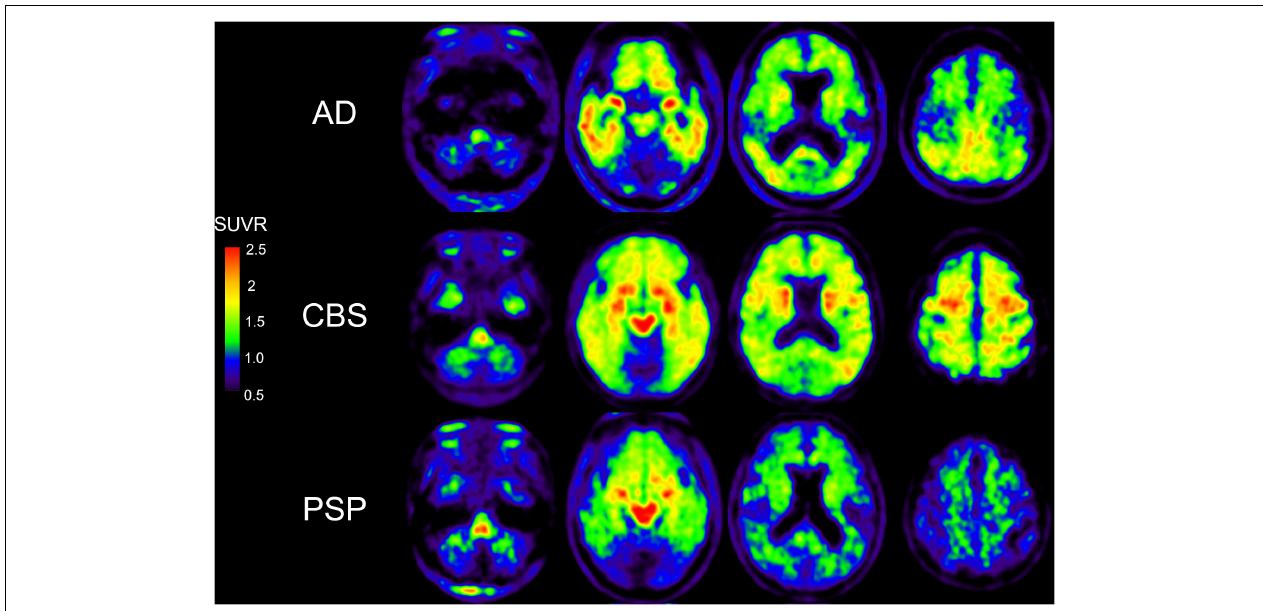
FIGURE 2 | [ 18 F]THK-5351 PET images in AD, CBS, and PSP subjects. [ 18 F]THK-5351 retention in the precentral gyrus clearly can distinguish CBS from PSP and AD. [ 18 F]THK-5351 retention in the midbrain distinguished PSP and CBS from AD (Okamura et al.,